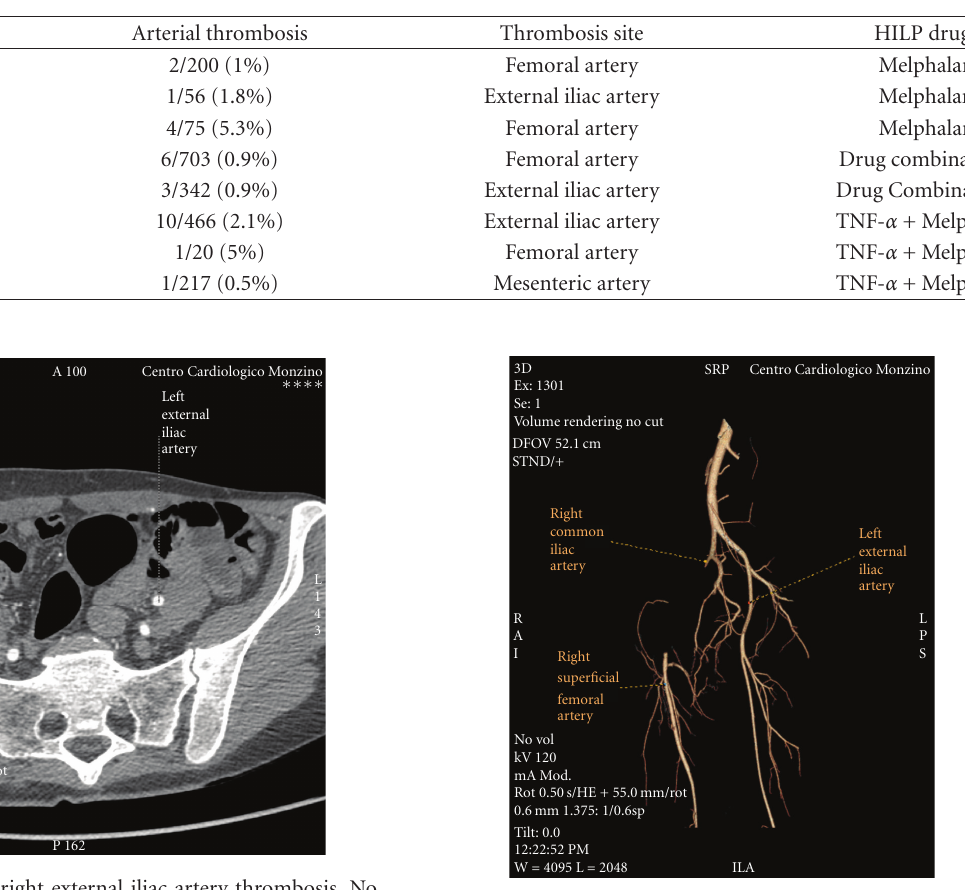
Table 1: Incidence of vascular complications after HILP in the literature.